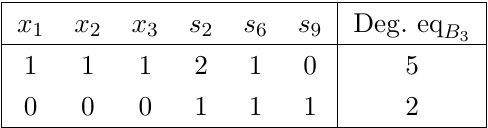
Table 5 . Degrees of the coordinates and of the equation de(cid:12)ning the base B 3 . A basis for H 1 ; 1 ( X ) is given by the divisor classes D 3 0 g \ X and D = f x = 0 g \ X . Their intersection polynomial in the Calabi-Yau 3 7 7 3